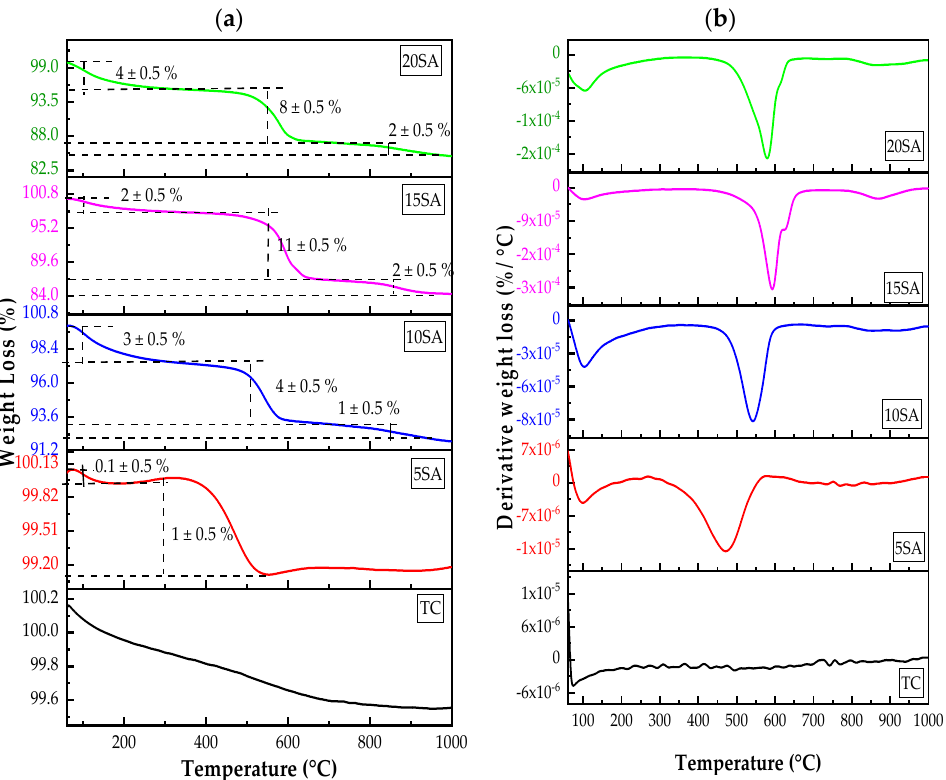
Figure 4. TGA ( a ) DTG ( b ) curve of non-sulphated and sulphated − titania catalysts at various concentration.